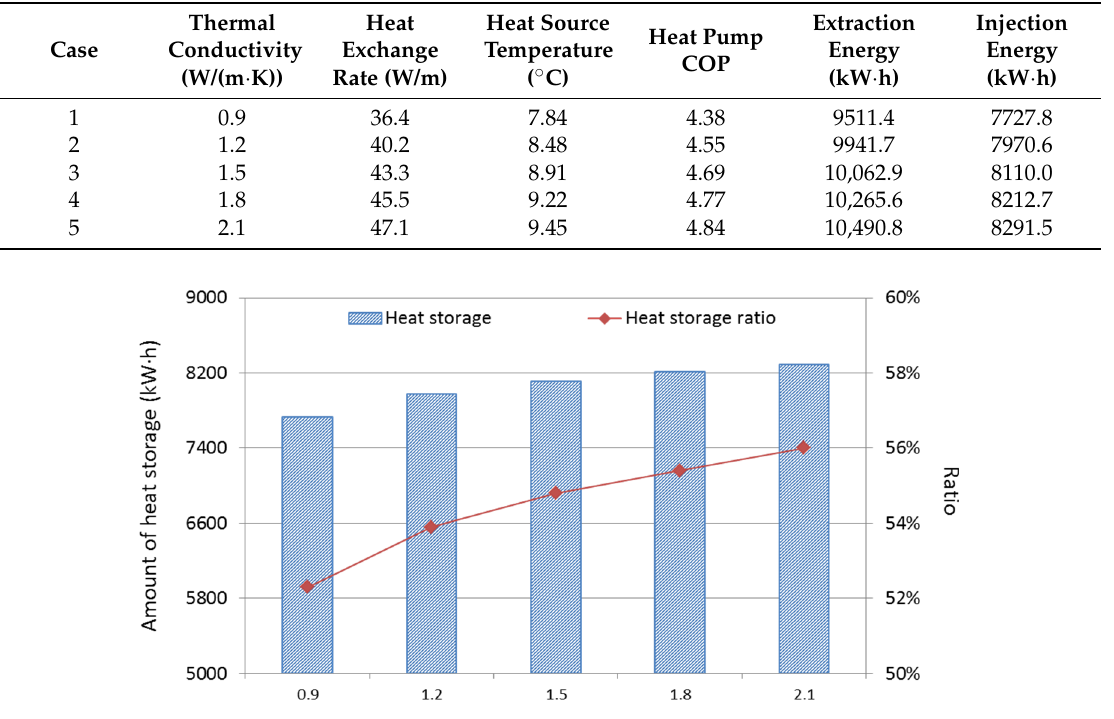
Table 5. Simulation results with different conductivity of grouting.